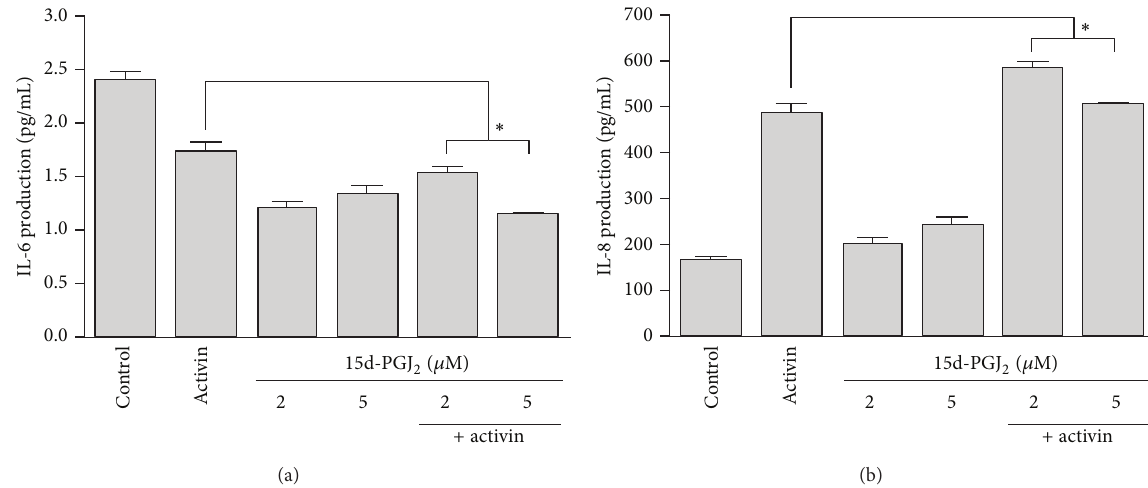
Figure 3: IL-6 and IL-8 production in HepG2 cells. Cells were stimulated with activin A (25 ng/mL) and 15d-PGJ 2 (2 or 5 𝜇 M) for 72h. The amounts of IL-6 (a) and IL-8 (b) in the cell culture supernatants were determined using ELISA. The data represent the mean ± SEM of 3 independent samples. ∗ 𝑃 < 0.05 , comparison of stimulation with 15d-PGJ 2 and activin A versus activin A stimulation alone.